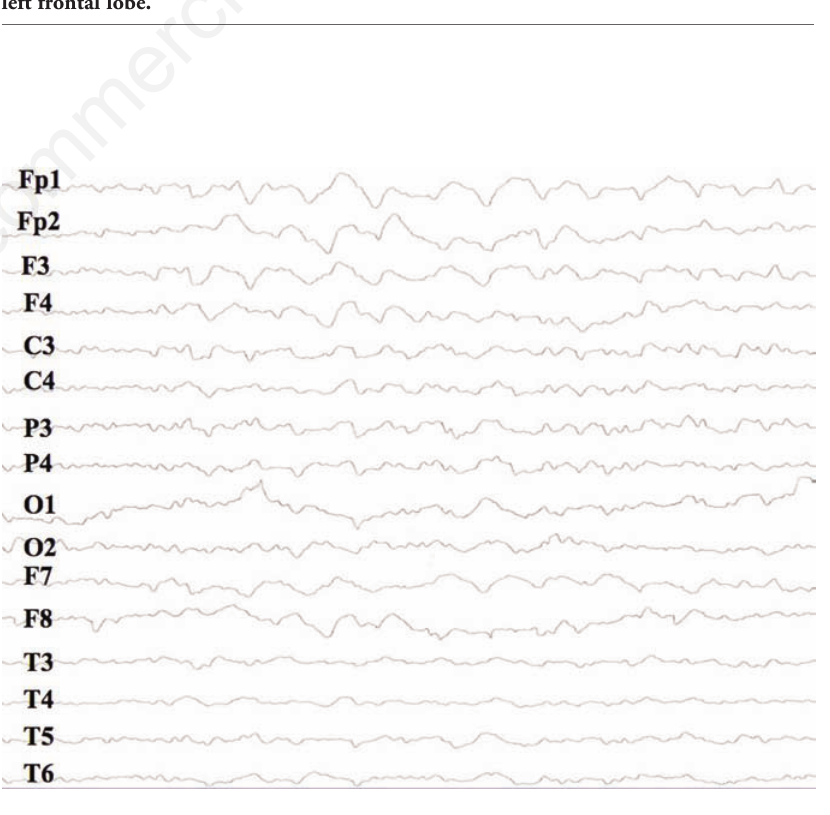
Figure 2. N-isopropyl-[ 123 I]p-iodoamphetamine single photon emission computed tomography showed hypoperfusion in the whole brain, which was predominant in the left frontal lobe.